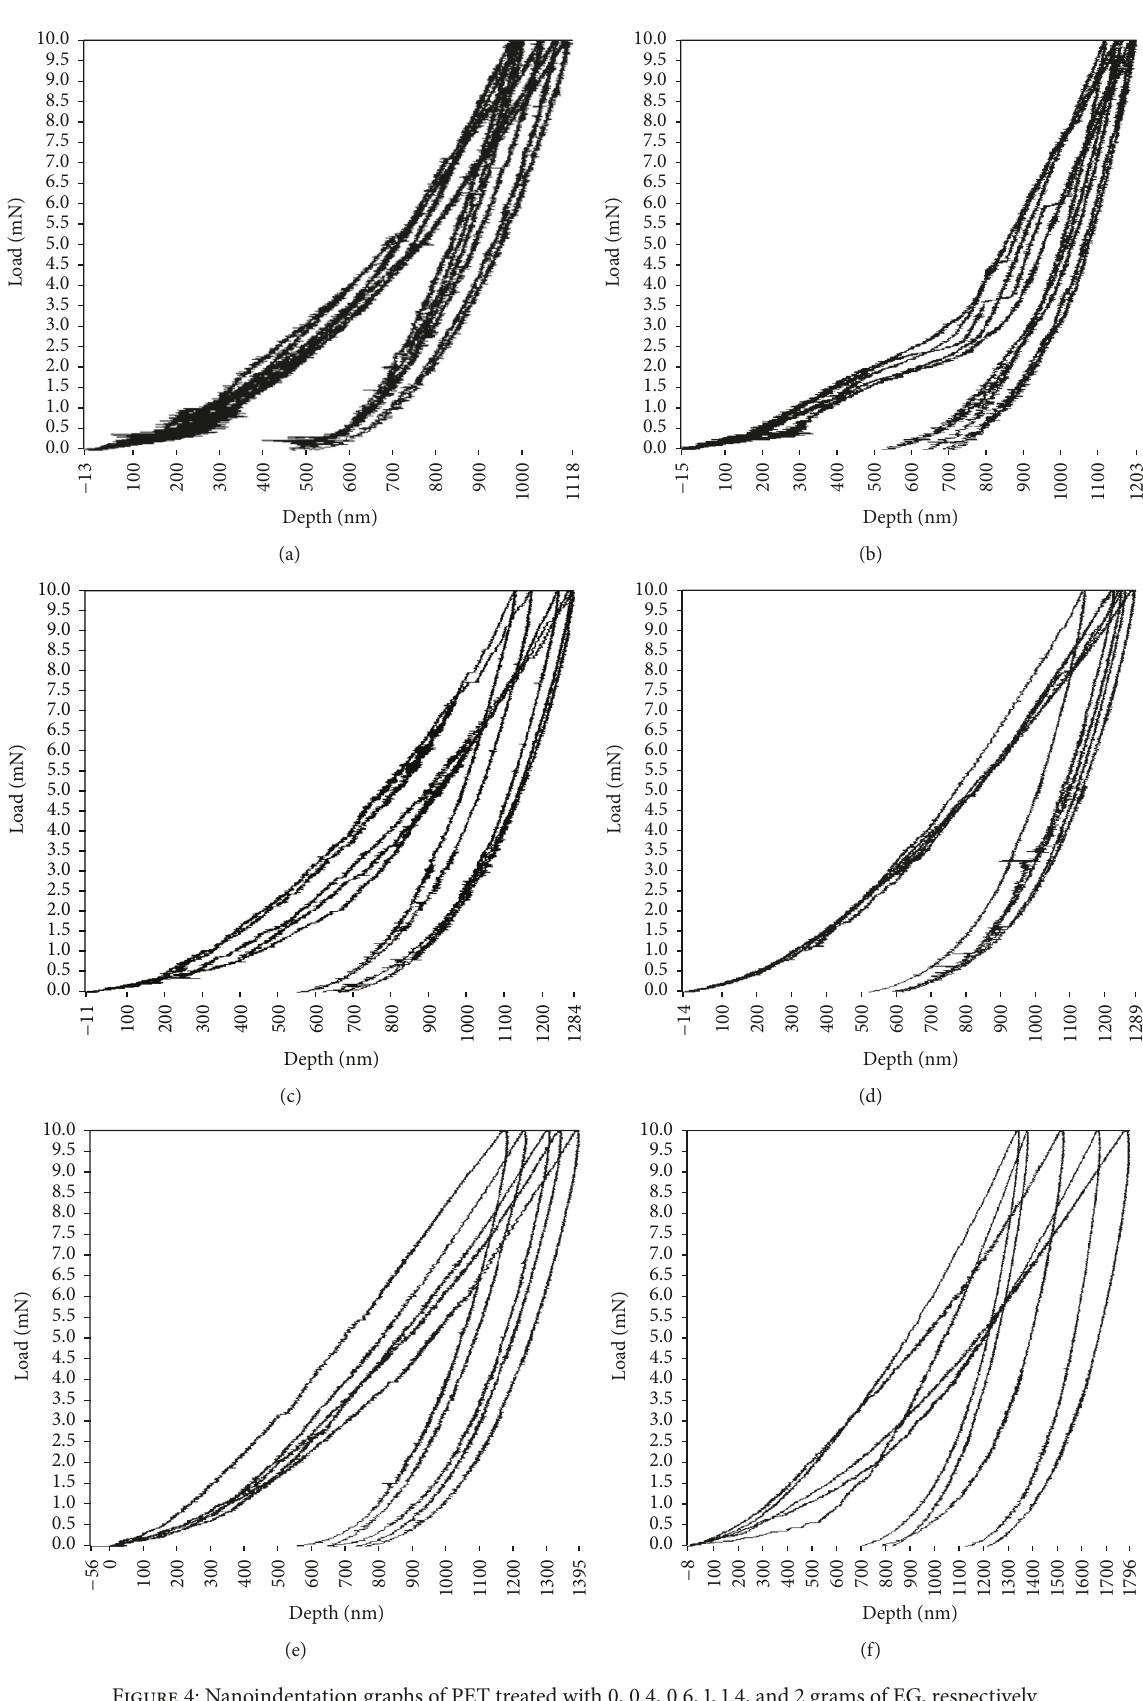
Figure 4: Nanoindentation graphs of PET treated with 0, 0.4, 0.6, 1, 1.4, and 2 grams of EG,